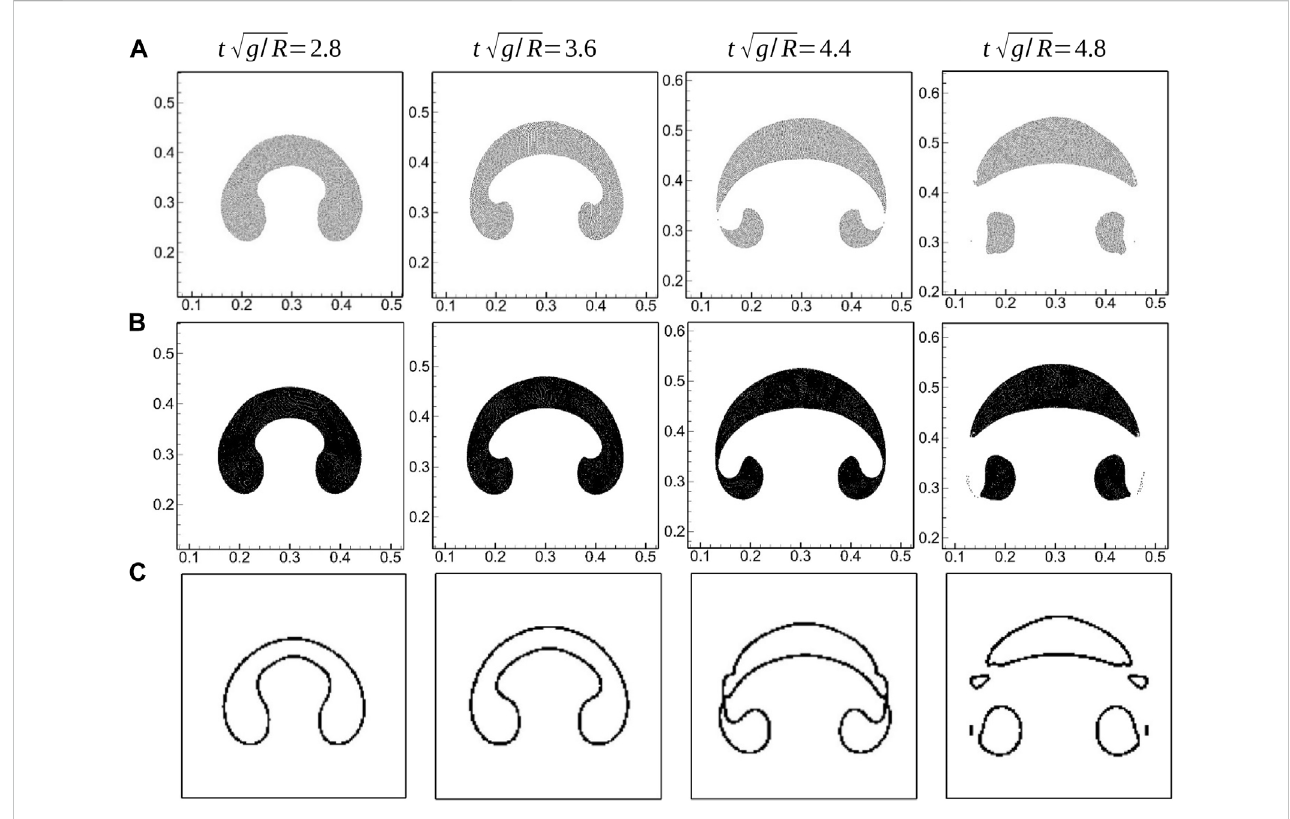
FIGURE 9 Snapshots of bubble rising. A MSPH-KGC solution with resolution of 192 × 320, B MSPH-KGC solution with resolution of 384 × 640, C Level set solution in (Sussman et al., 1994).